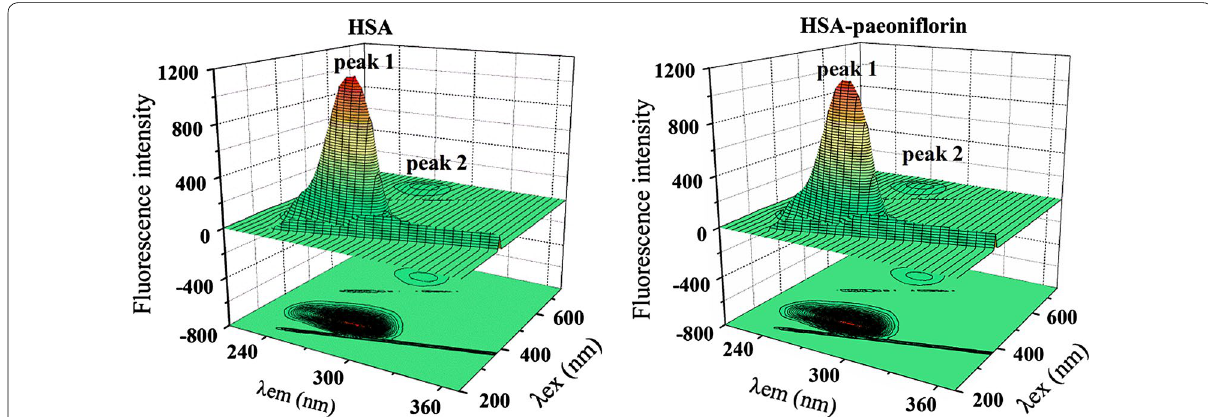
Fig. 9 Three‑dimensional fluorescence spectra and corresponding contour diagrams of free HSA, HSA ([HSA]